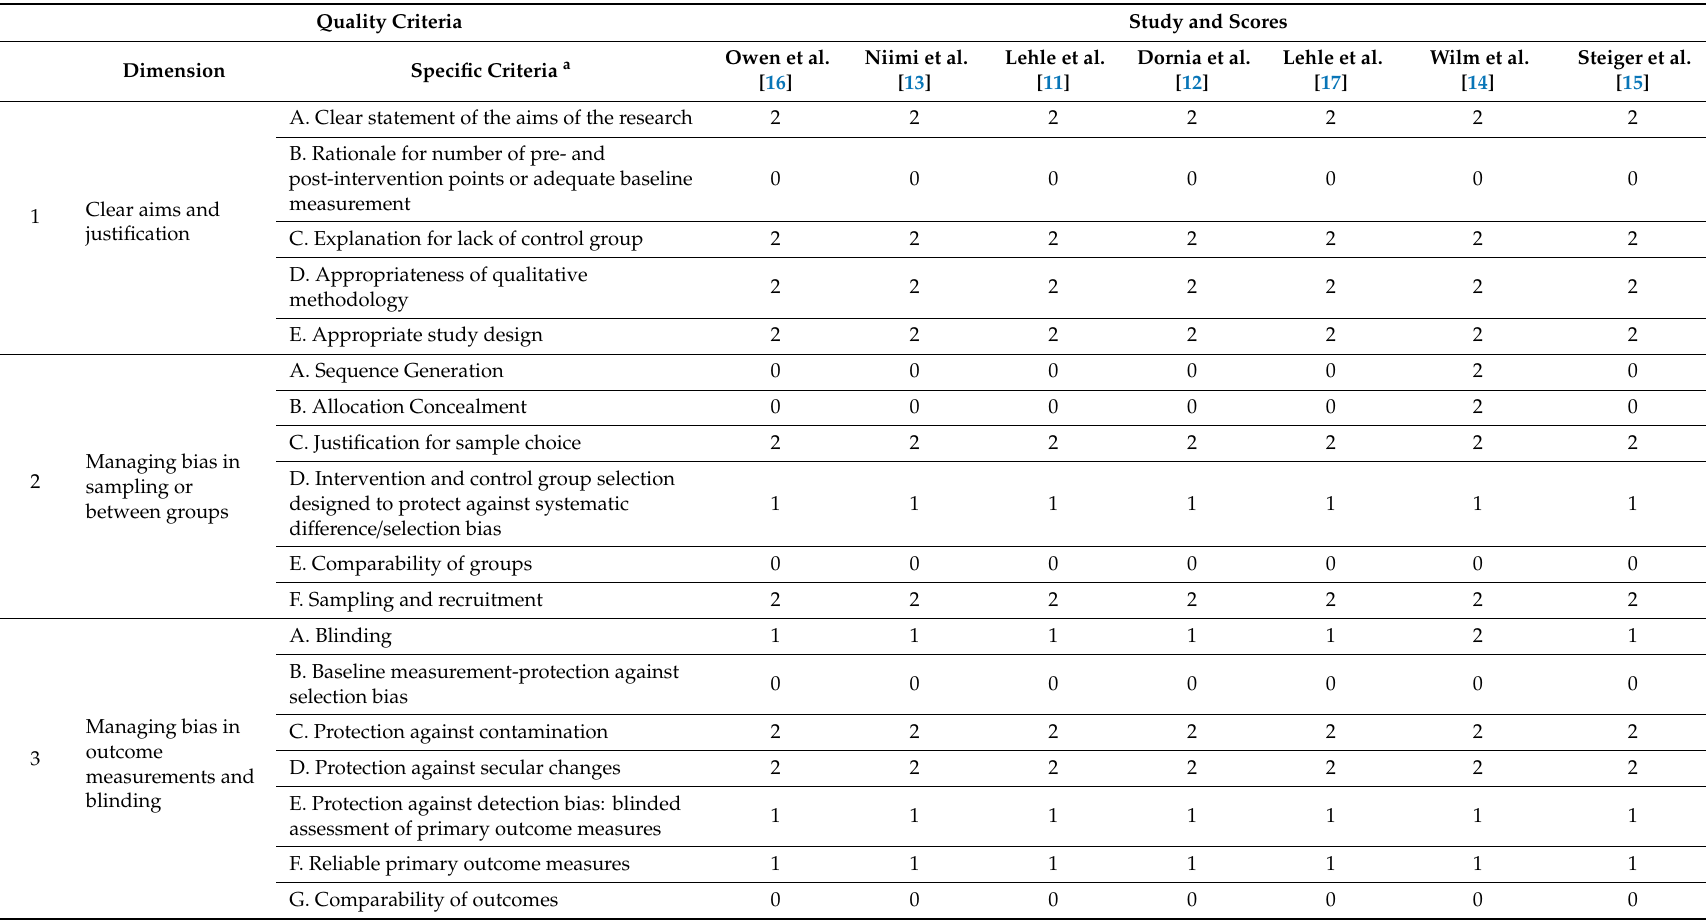
Table A1. Risk of bias assessment of the studies included in the systematic